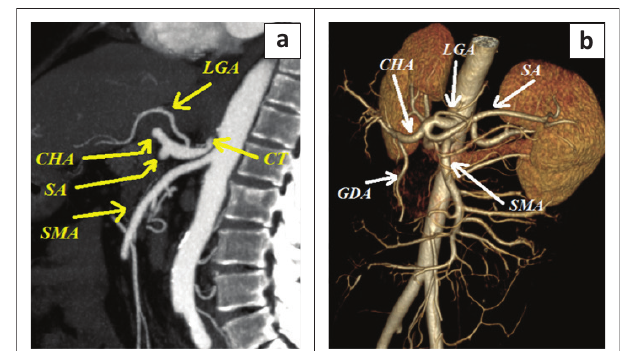
FIGURE 2: Type 1 classic trifurcation. Coronal multi-planar reconstruction image (a) and three-dimensional reconstruction images (b) show a type I coeliac classic trifurcation. Additionally, there is a replaced right hepatic artery.